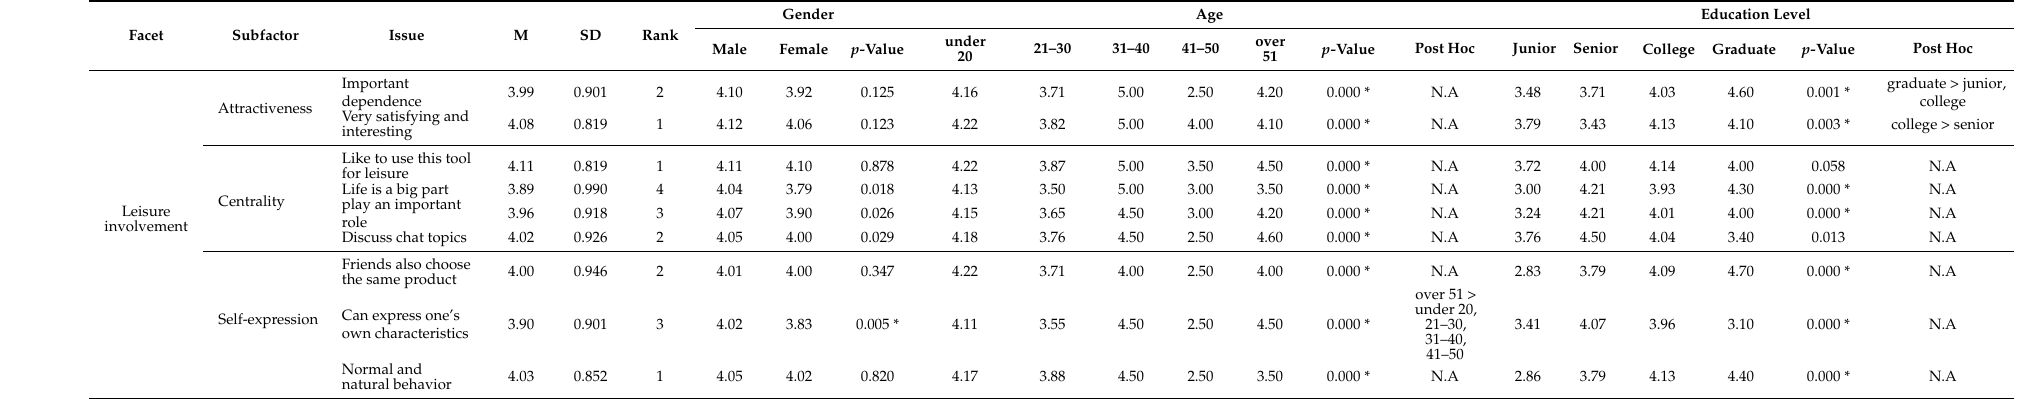
Table 5. Analysis of cognitive differences in leisure involvement.